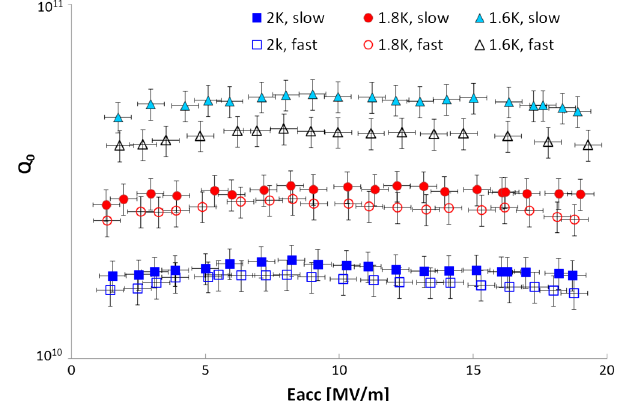
FIG. 7. Cavity Q s of the ERL7-3 cavity (dressed) for different temperatures and different cooldown cycles. The undressed cavity tested within the error bars like the dressed cavity under slow